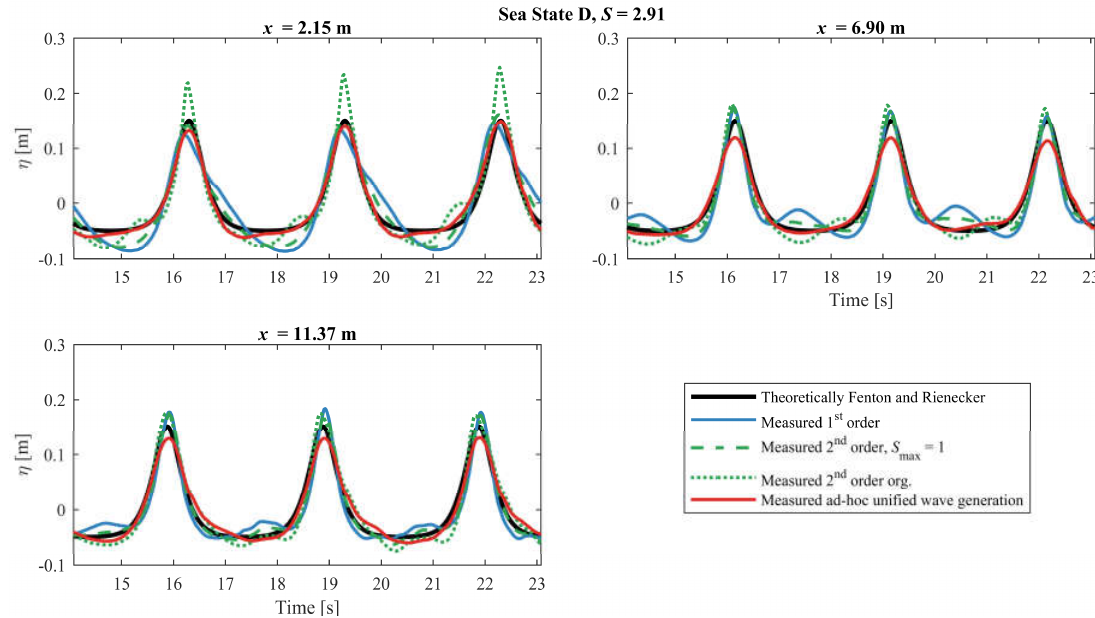
Figure 8. Theoretically surface elevation compared with the first-order, second-order, modified second-order and the ad-hoc unified wavemaker methods for Sea State D.